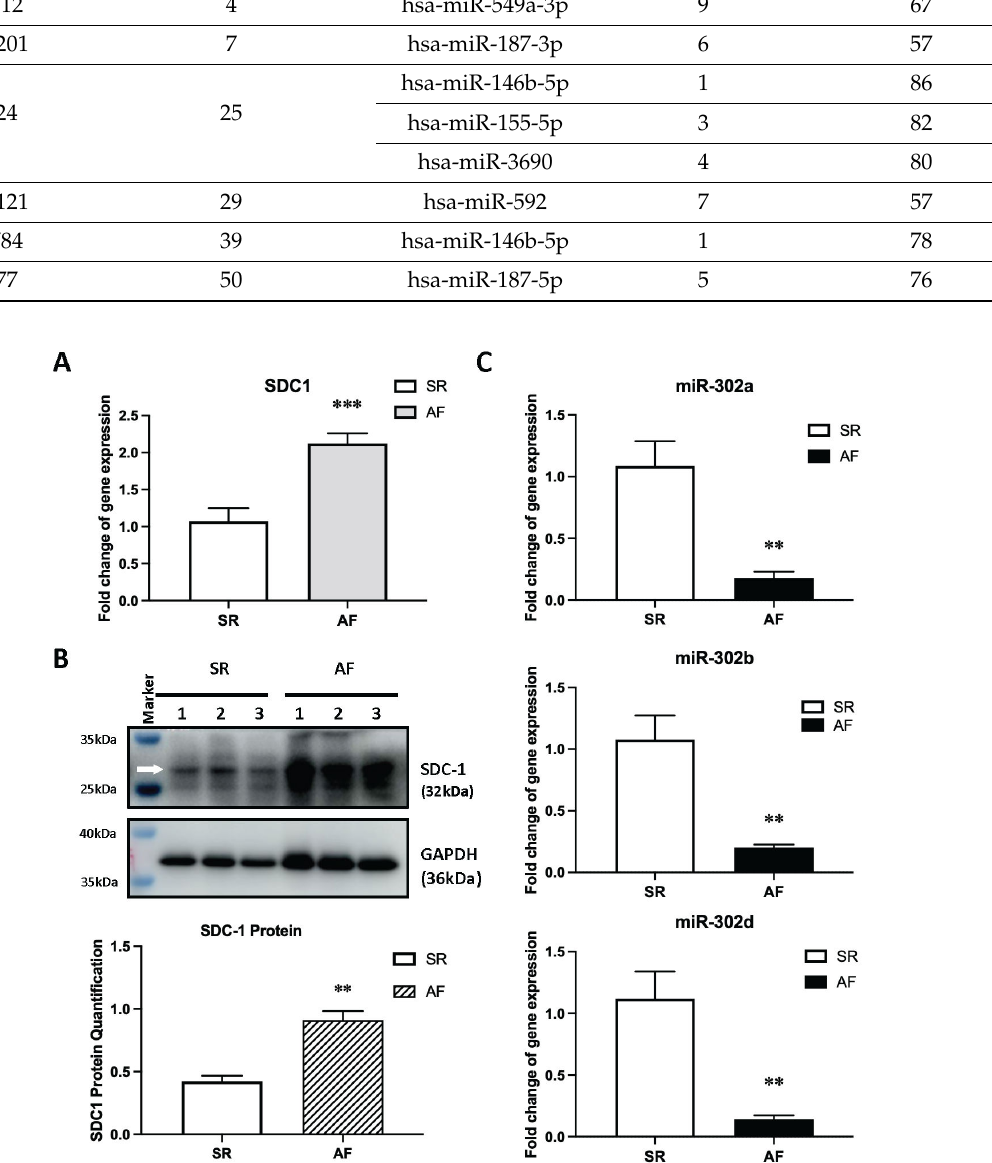
Figure 6. Validating expression of miR-302b-3p and SDC-1 in human atrial tissue. ( A , B ) Expression of SDC-1 ( A ) mRNA ( n = 6) and ( B ) protein ( n = 3) in SR (sinus rhythm) vs. AF atrial tissue samples. ( C ) Expression levels of miR-302 family in atrial tissue samples of the SR vs. AF groups ( n = 6). ** p < 0.01 or *** p <